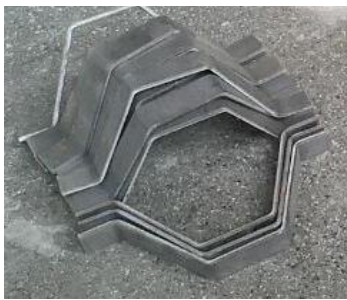
Figure 5. CSC shear connectors. Figure 5. CSC shear